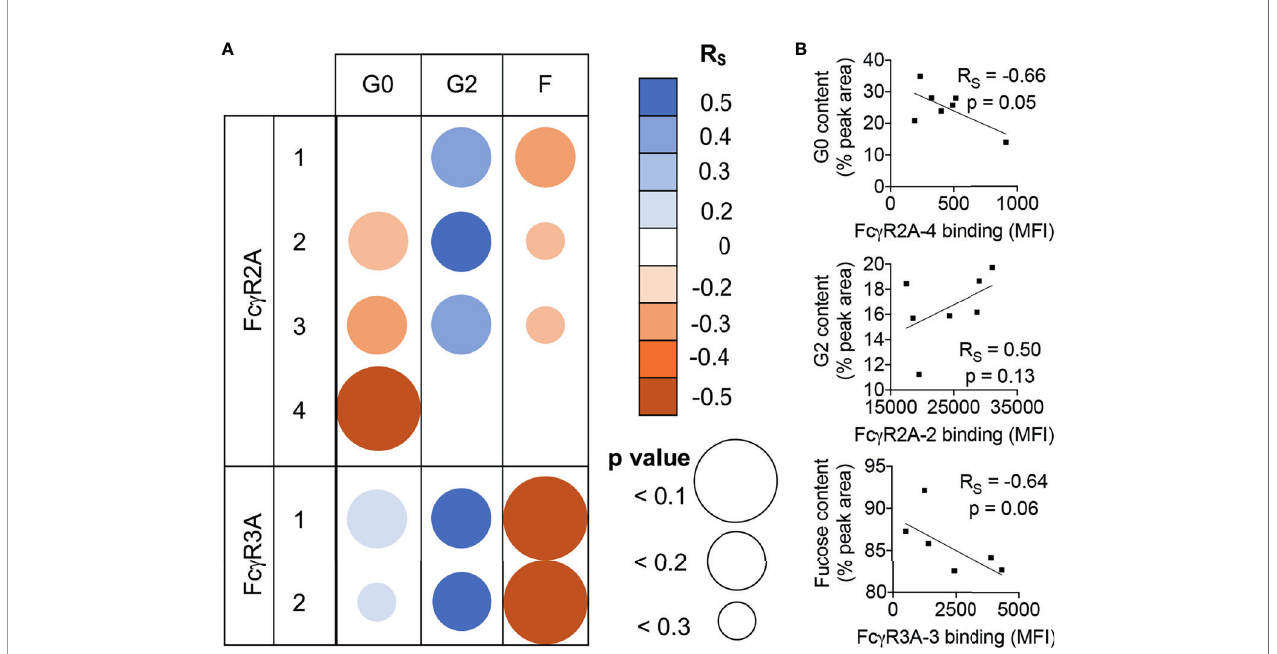
FIGURE 6 | Similar Fc g R binding glycopreferences are observed for RM serum IgG. (A) Correlations of receptor binding signal in multiplex assay and glycan species prevalence in rhesus macaque serum IgG for each allotypic variant of RM Fc g RIIa and Fc g RIIIa. Unadjusted Spearman correlation coef fi cient (R S ) strength and direction are indicated in color, and con fi dence (p value) in size. (B) Exemplary scatter plots of relatively stronger correlative relationships between relative galactose and fucose content (% peak area) in relation to Fc g R binding median fl uorescent intensity (MFI). Correlation coef fi cients and exact p values are indicated in